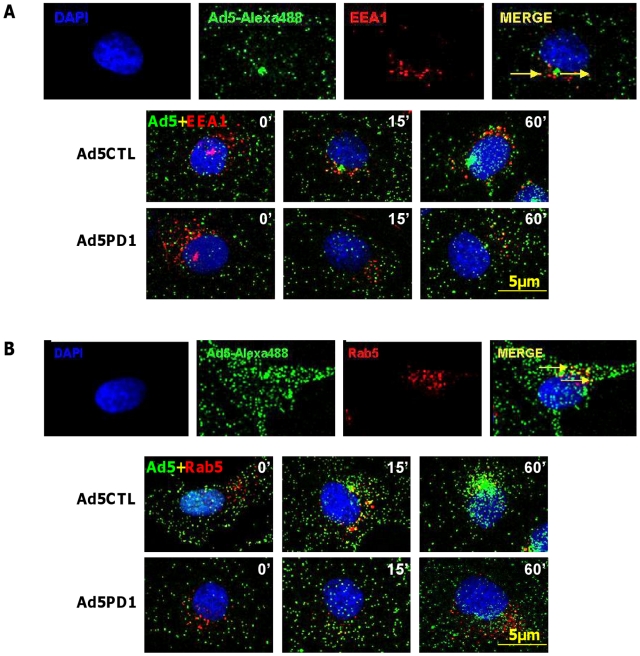
Endosomal localisation of αv integrin binding-defective Ad5 in vitro.(A+B) 10,000 vp/cell of Alexa488-labelled Ad5CTL or Ad5PD1 (green particles) in the presence of FX were allowed to bind cells for 1 h at 4°C, then incubated at 37°C for increasing lengths of time (15 min, 60 min) to allow internalisation and trafficking prior to fixation and staining for the early endosome markers EEA1 (A) or Rab5 (B). Specific binding of primary antibodies against EEA1 (A, upper panel) or Rab5 (B, upper panel) was detected using a Alexa546-labelled secondary antibody (red). Nuclei were counterstained using DAPI. Images were captured on a confocal microscope under a 63× objective.